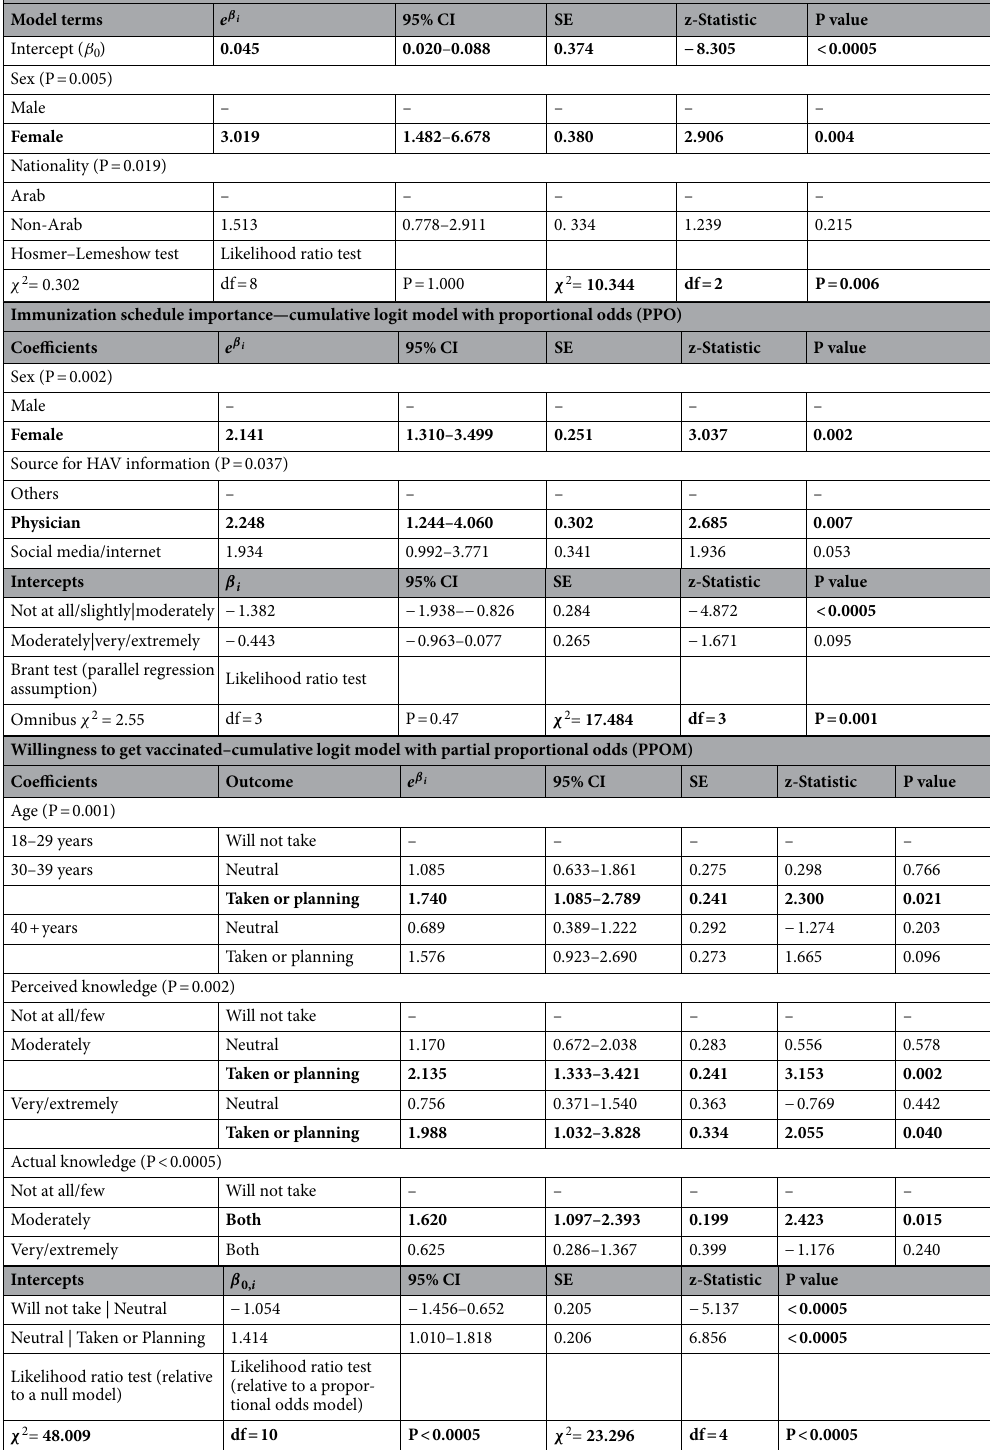
Table 3. Binary and ordinal logistic regression models. The table represents the results of the logistic and ordinal regression models. The lower and upper bounds of the confidence interval were exponentiated for easier interpretation. CI Confidence Interval, SE standard error, HAV Hepatitis A